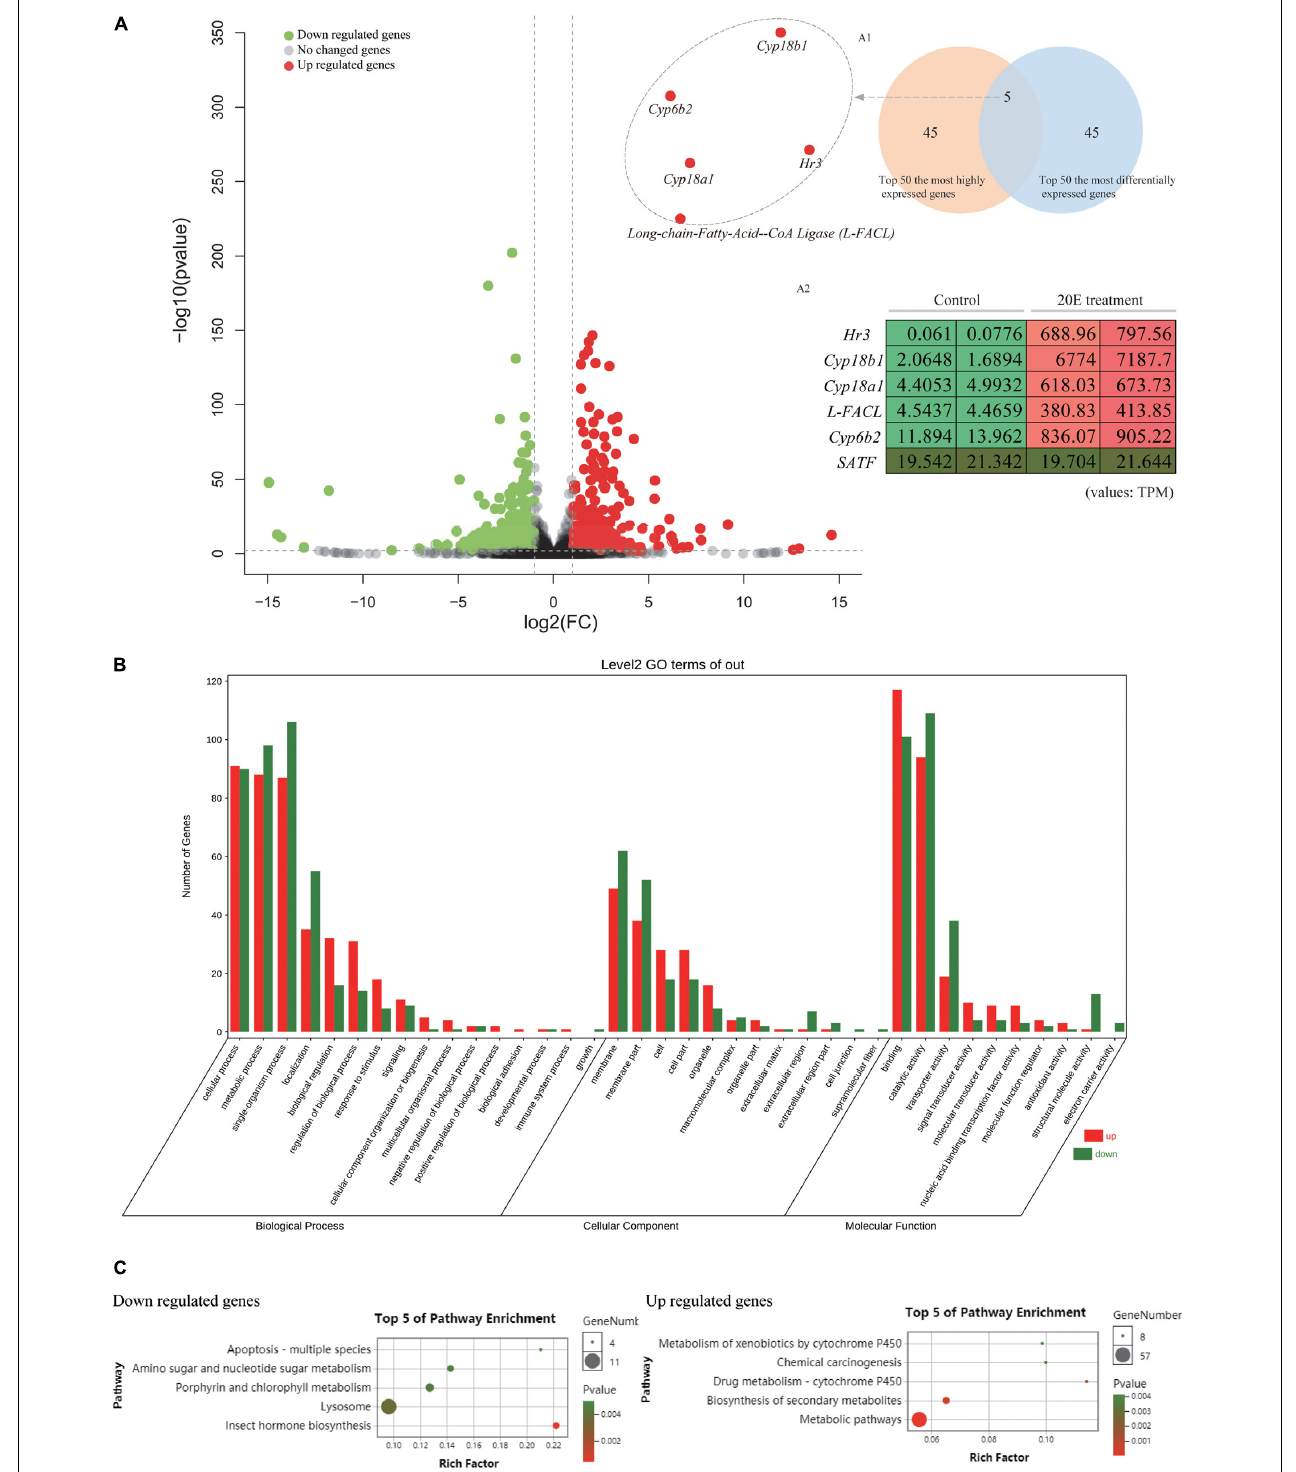
FIGURE 3 | Comparative transcriptome analysis of the larvae midgut after control and 20E treatment. (A) Volcano plot of the fold change of transcripts in 20E treated larvae midgut compared to control; Inner figure A1 represents Venn diagram between top 50 most differentially expressed genes and top 50 most highly expressed genes in 20E treatment sample; Inner figure A2 represents the TPM value of the candidate genes identified by Venn diagram; TPM means transcripts per million. (B) Gene ontology analysis of the differently expressed genes between control and 20E treated sample. (C) KEGG analysis of the differently expressed genes between control and 20E treated